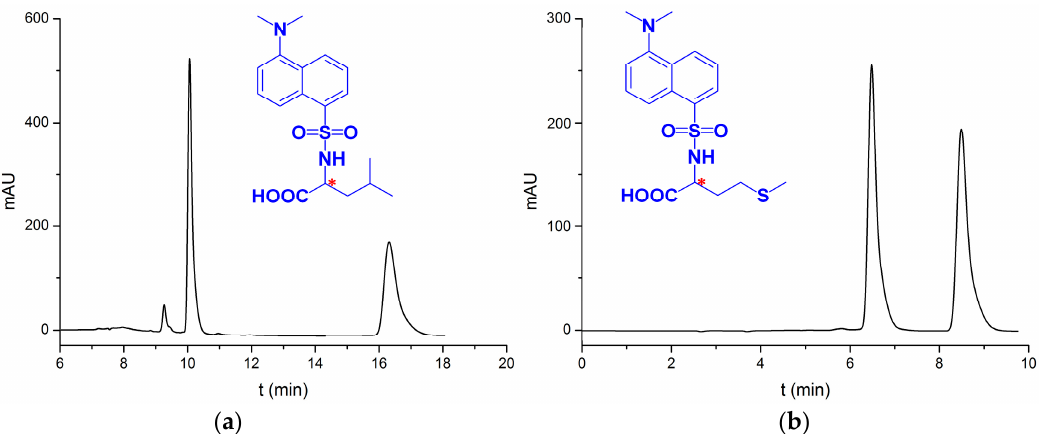
Figure 5. Representative chromatograms on Triazole-CD-CSP. Conditions: 1% TEAA buffer (pH 4.11)/MeOH (50/50 v / v ); flow rate = 0.8 mL/min. ( a ) Dansyl amino leucine; ( b ) Dansyl amino methionine.